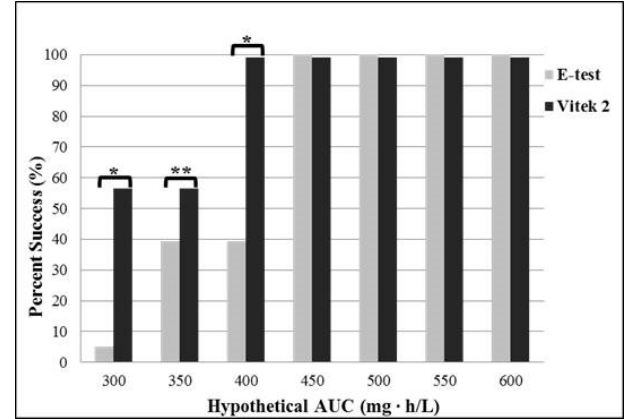
Figure 2. Frequency distribution of vancomycin area under the serum concentration time curve to minimum inhibitory concentration (AUC/MIC) ratio targeted attainment for each assumed AUC. The asterisk mark indicates statistical significance. ** p < 0.001; * p < 0.01 for McNemar’s test. Abbreviations: AUC, area under the serum concentration time curve.